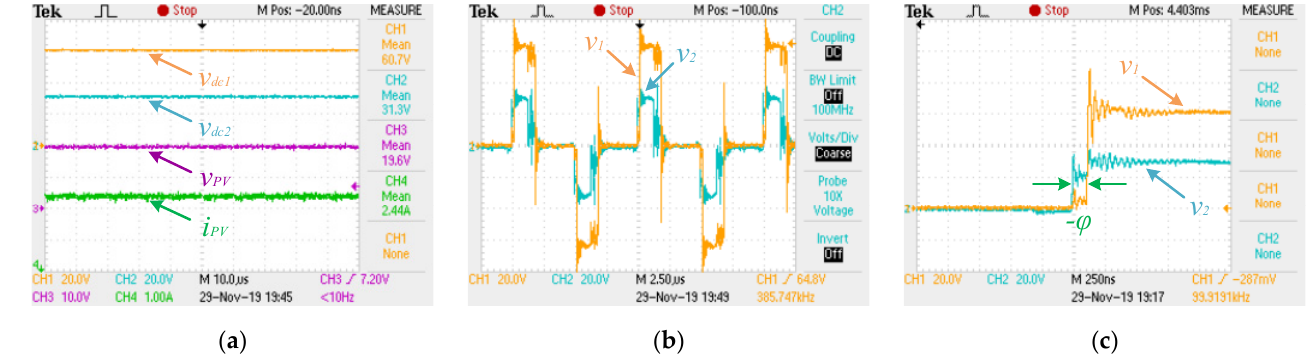
Figure 8. PV2G operation mode with a DPS control algorithm: ( a ) voltage on the primary (CH1: 20 V/div) and secondary dc-link (CH2: 20 V/div), voltage on the solar PV panels (CH3: 10 V/div), current at the solar PV panels (CH4: 1 A/div); ( b ) voltage on the high-frequency transformer primary (CH1: 20 V/div) and secondary side (CH2: 20 V/div) in a steady-state; ( c ) voltage on the high-frequency transformer primary (CH1: 20 V/div) and secondary side (CH2: 20 V/div), detailing the negative phase lag ( − φ ).